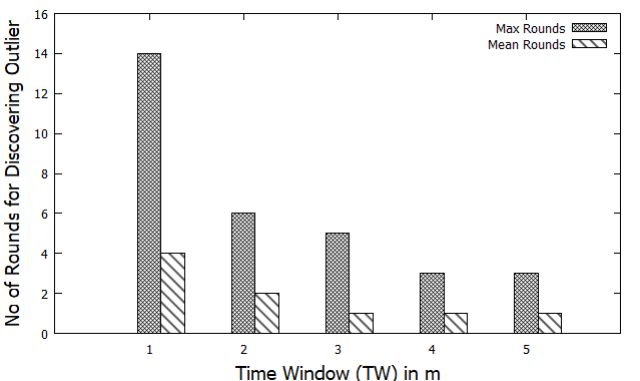
Figure 9. Effects of varying the time window (TW) on the number of rounds to discovered outliers’ trajectories.